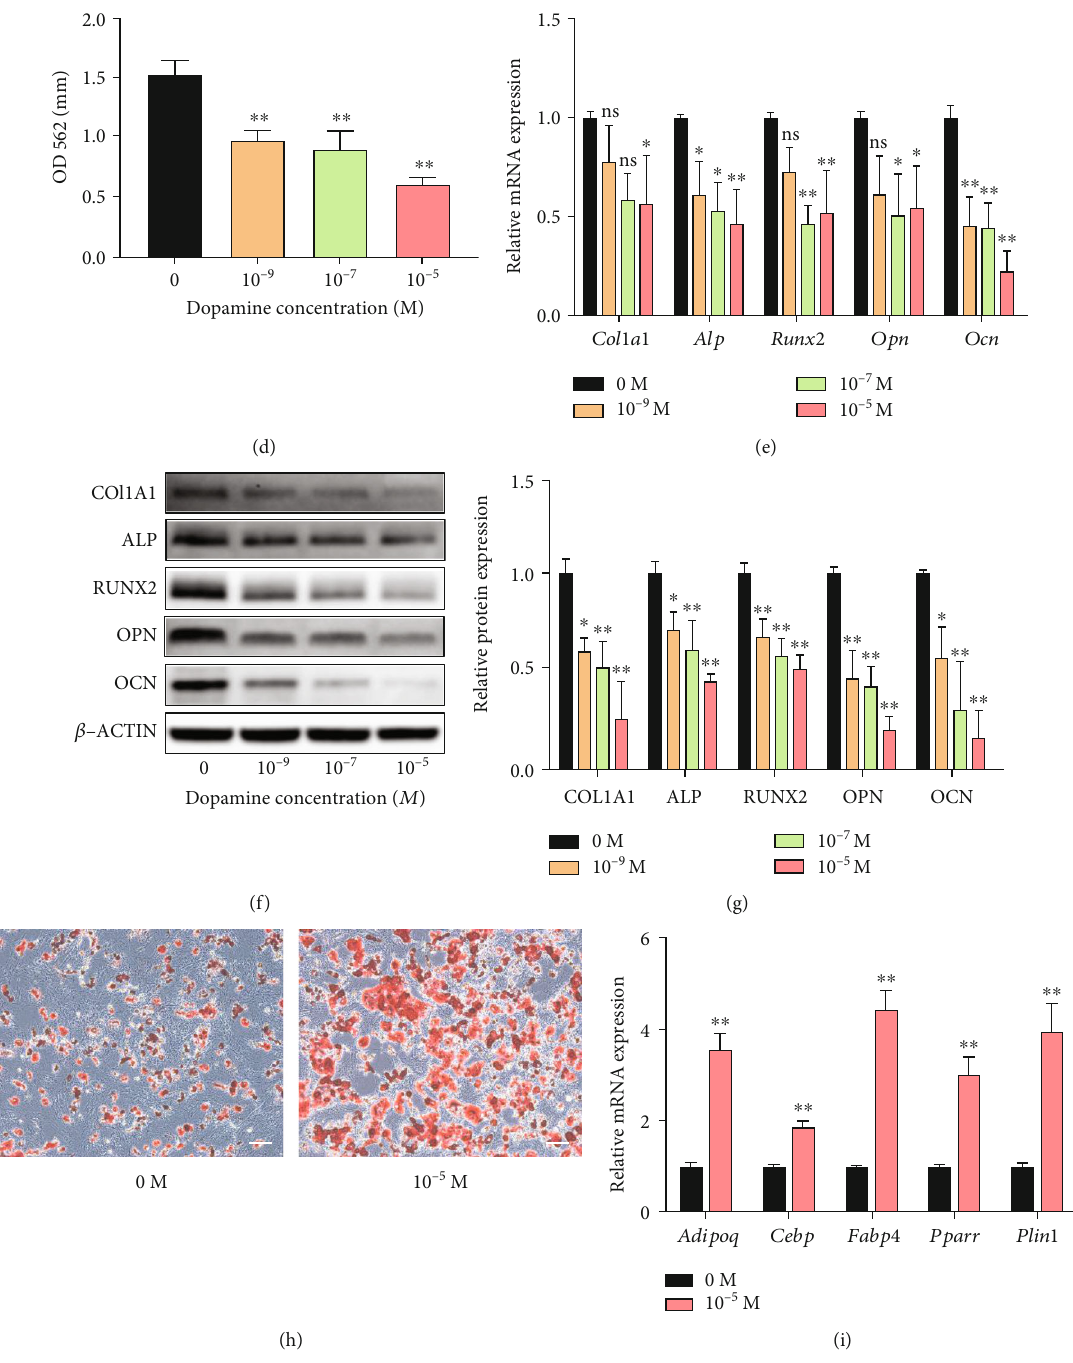
Figure 3: DA inhibits osteogenic di ff erentiation and promotes adipogenic di ff erentiation of rBMSCs. (a) ALP staining of rBMSCs treated with di ff erent concentrations of DA after 7 days of di ff erentiation. Optical photos (upper photo) and microscopic images (lower photo). (b) ALP activity of rBMSCs treated with di ff erent concentrations of DA after 7 days of di ff erentiation. (c) Calcium nodules assessed by Alizarin Red staining after 14-day osteogenic induction. Optical photos (upper photo) and microscopic images (lower photo). (d) Semiquanti fi cation of Alizarin Red staining. (e) The e ff ect of DA on osteogenic-related mRNA expression in rBMSCs evaluated by qRT- PCR assay after 7 days of di ff erentiation. (f, g) The expression levels of osteogenic-related proteins (COL1A1, ALP, RUNX2, OPN, and OCN) detected by western blot. (f) and quanti fi ed (g) in the indicated groups with 7-day osteogenic induction. (h) Oil Red “ O ” staining of rBMSCs treated with di ff erent concentrations of DA after 14-day adipogenic induction. (i) The e ff ect of DA on adipogenic-related mRNA ( Adipoq , Cebp , Fabp4 , Pparr , and Plin1 ) expression in rBMSCs evaluated by qRT-PCR assay after 14-day adipogenic induction. Scale bar, 100 μ m. ∗ p < 0 : 05 and ∗∗ p < 0 : 01